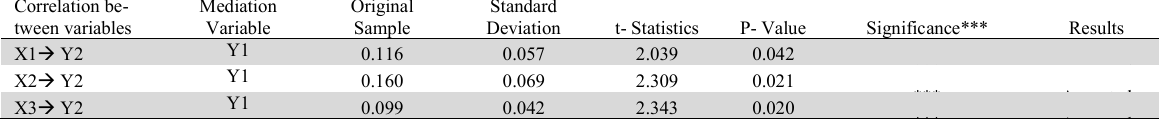
Indirect Effects of Exogenous Variables on Endogenous Variables through Mediation Variables Correlation be- Mediation tween variables